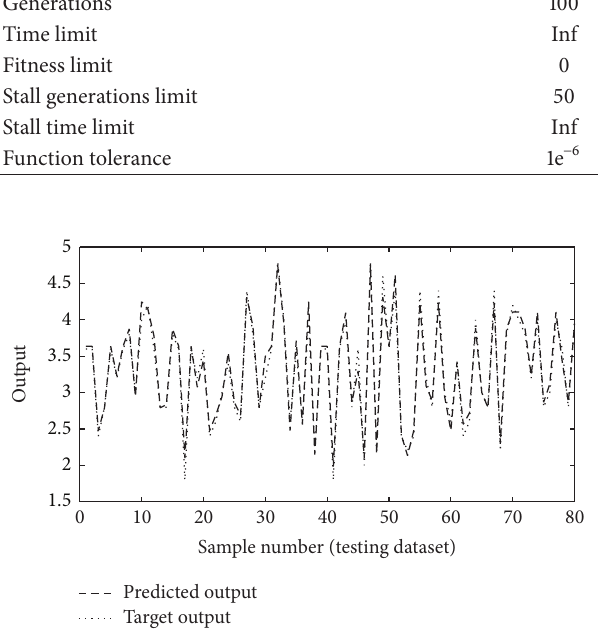
Figure 4: Comparison between target output and predicted